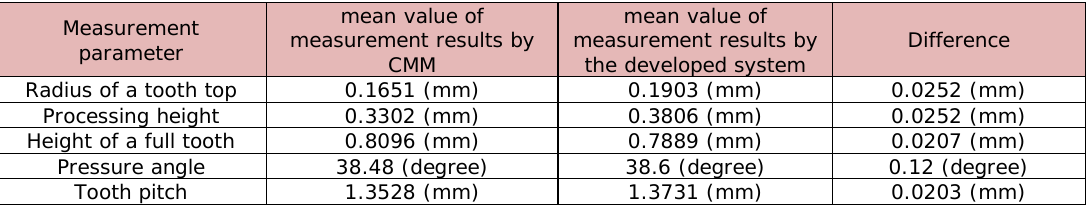
Table 3. “Accuracy analysis (middle ten teeth)”.